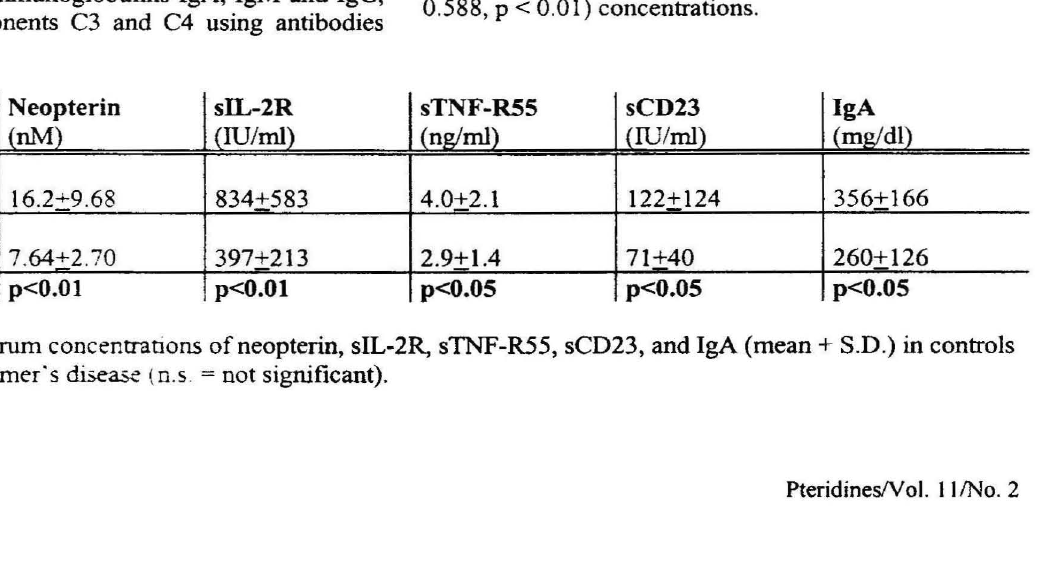
Table 2: Age and serum concentrations ofneopterin, sIL-2R, sTNF-R55, sCD23, and IgA (mean + S.D.) in controls patients with Alzheimer's disease (n.s. = not